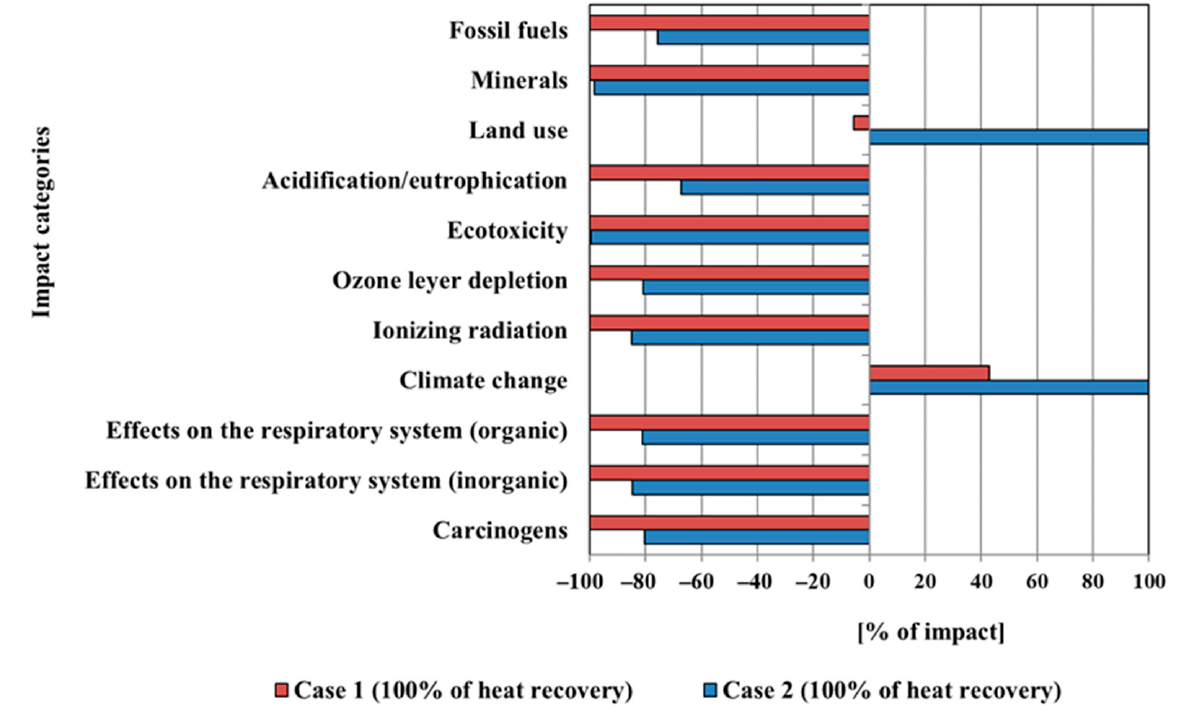
Figure 9. The results of the life cycle comparative analysis of 1 MWh of electricity-generating from biogas for Case 1 and Case 2 with 100% thermal energy utilization for individual impact categories under the Eco–Indicator 99 method (characterization).